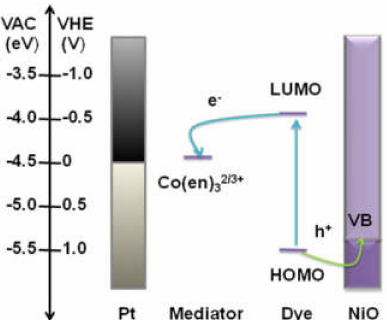
Figure 1. Energy level diagram for the prepared p -type dye-sensitized solar cell ( p